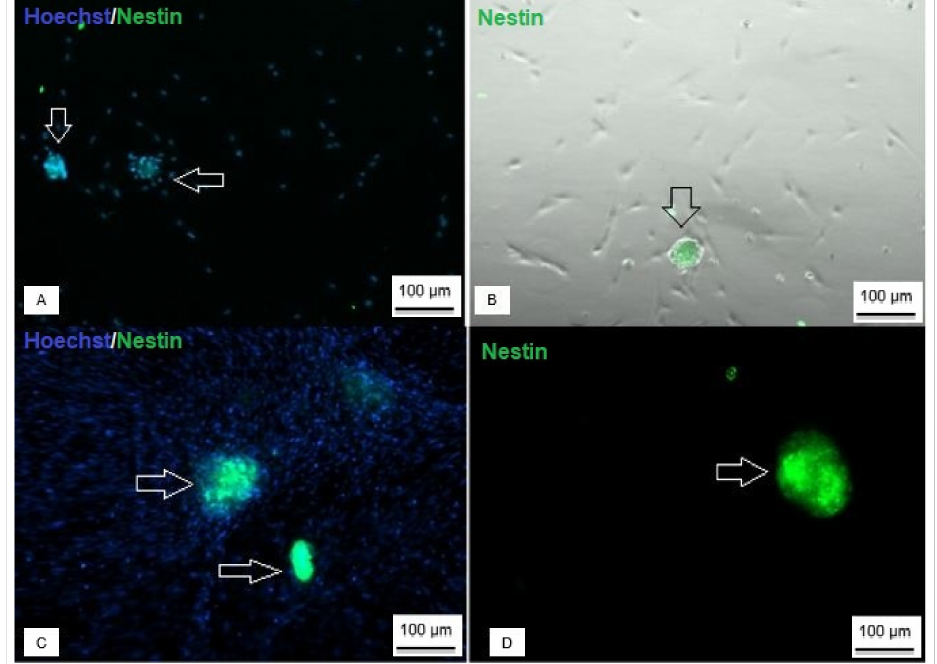
Figure 8. Immunocytochemistry of neurospheres derived from UCB-MSC and WJ-MSC. ( A ) Neuro- sphere derived from UCB-MSC with nuclear staining (blue) and positive staining for Nestin protein (green); ( B ) phase contrast identifying positive staining for Nestin; ( C ) WJ-MSC-derived neurosphere with nuclear labeling (blue) and positive labeling for Nestin (green); ( D ) positive marking for Nestin (Axio Vert A1, Car Zeiss, Oberkochen, Germany—100 X).